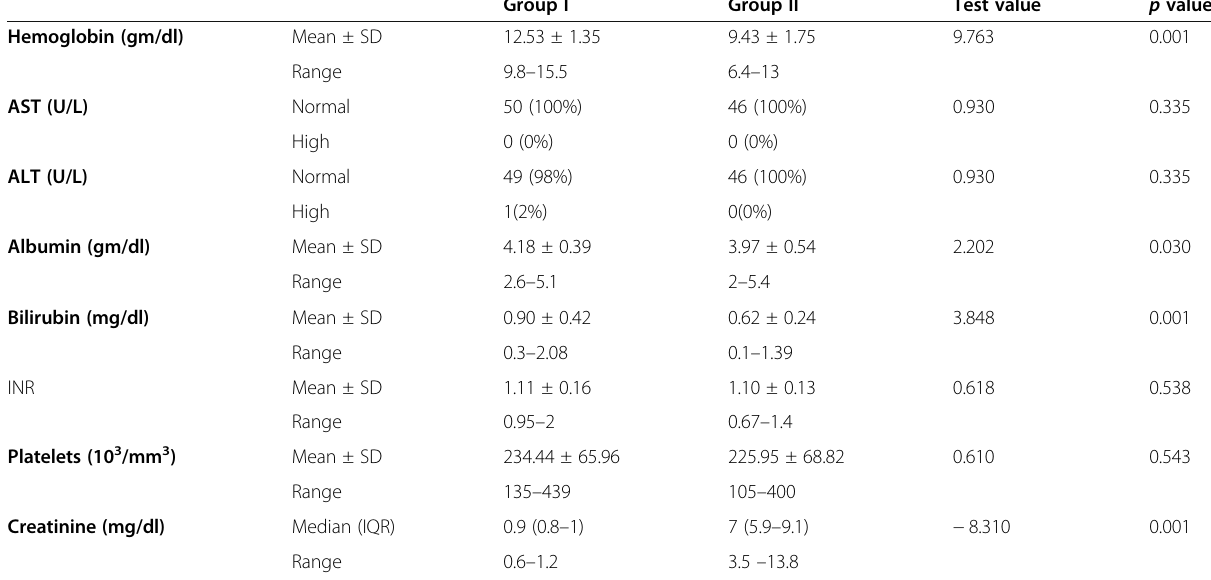
Table 5 Comparison between group I (control group) and group II (case group) regarding levels of hemoglobin, AST, ALT, albumin, total bilirubin, INR, platelets, and creatinine 8 weeks after treatment